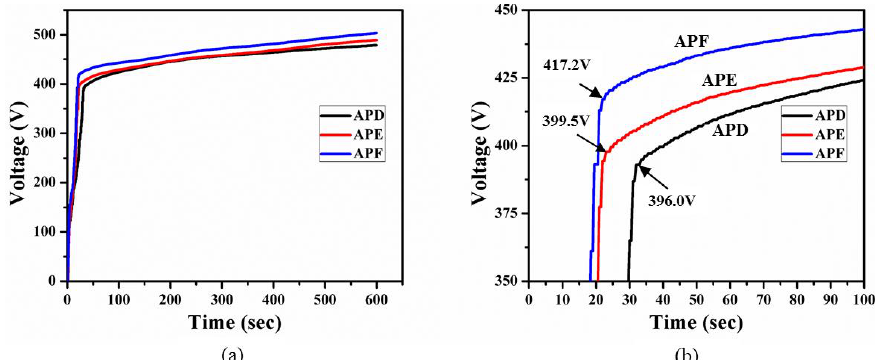
Figure 2. The voltage‐time responses of PEO processes ( a ) with different duty cycles and ( b ) the enlarged plots from 0 to 100 s indicated with the breakdown voltage values. enlarged plots from 0 to 100 s indicated with the breakdown voltage values.